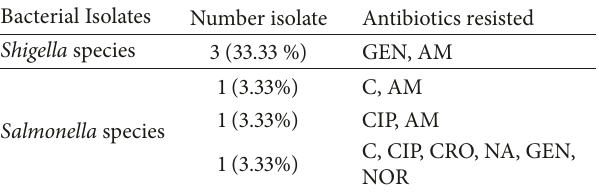
Table 3: Multidrug resistance pattern of Salmonella and Shigella species from diarrheal patients attending Nekemte Referral Hospi- tal, October 2015 to February